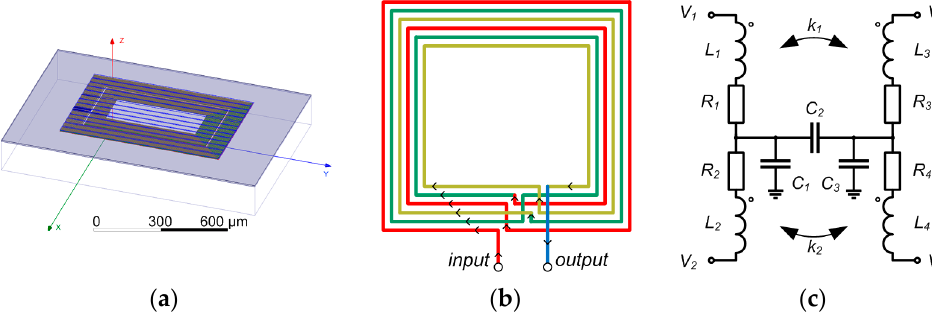
Figure 3. ( a ) The 3D model of a single microtransformer introduced into the parasitic extraction software; ( b ) The winding structure used in the microtransformers. Layer thicknesses and color coding are given in Figure 4a; ( c ) The model circuit of a single microtransformer. The components’ values are given in Table 1.